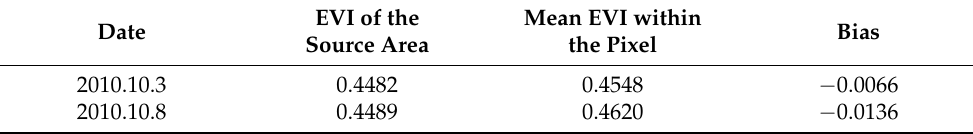
Table 2. Comparison of EVI within the flux source area and the pixels of GOME-2 SIF